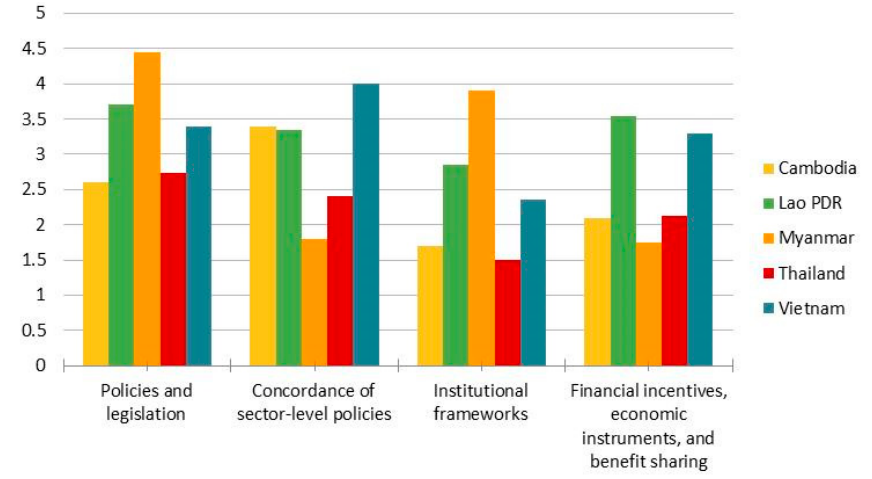
Figure 2. Average score per component of Pillar 1 for each country.